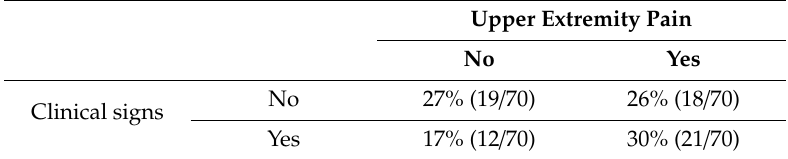
Table 8. Cross table with clinical signs (diagnoses) and upper extremity pain (symptoms).